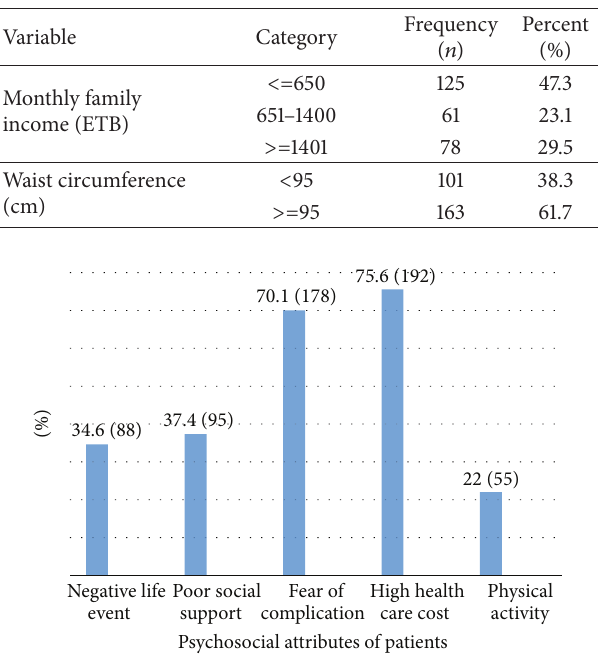
Figure 2: Distribution of psychosocial attributes among type 2 diabetic outpatients in Black Lion General Specialized Hospital, Addis Ababa, Ethiopia,